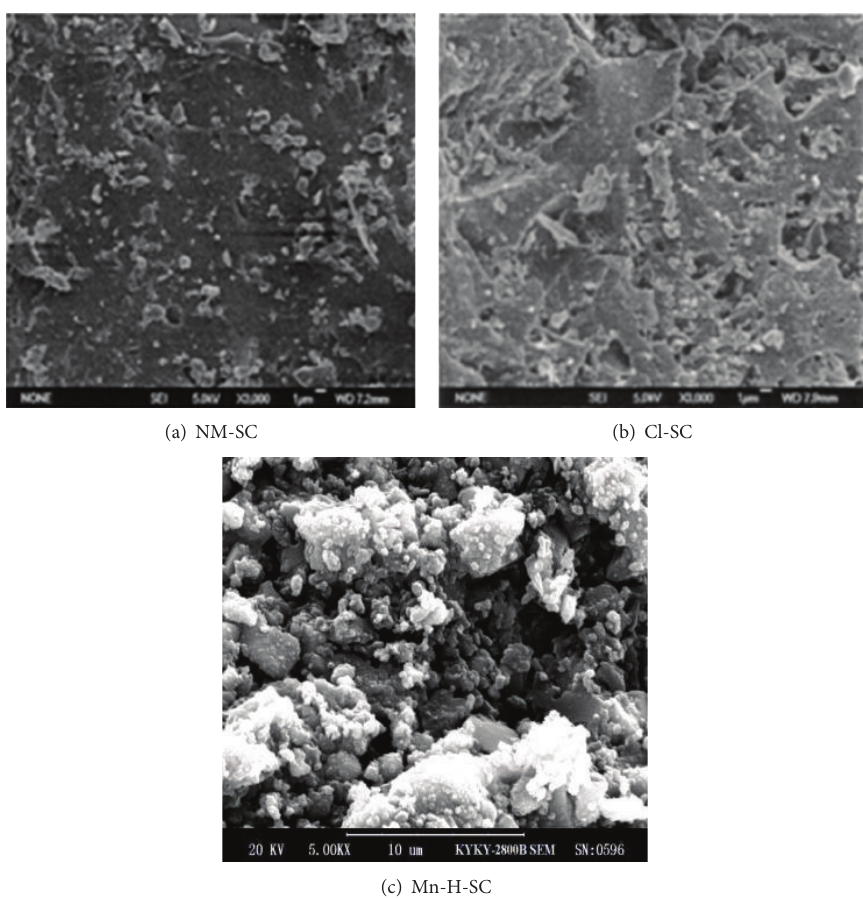
Figure 1: SEM images of NM-SC, Cl-SC, and Mn-H-SC.